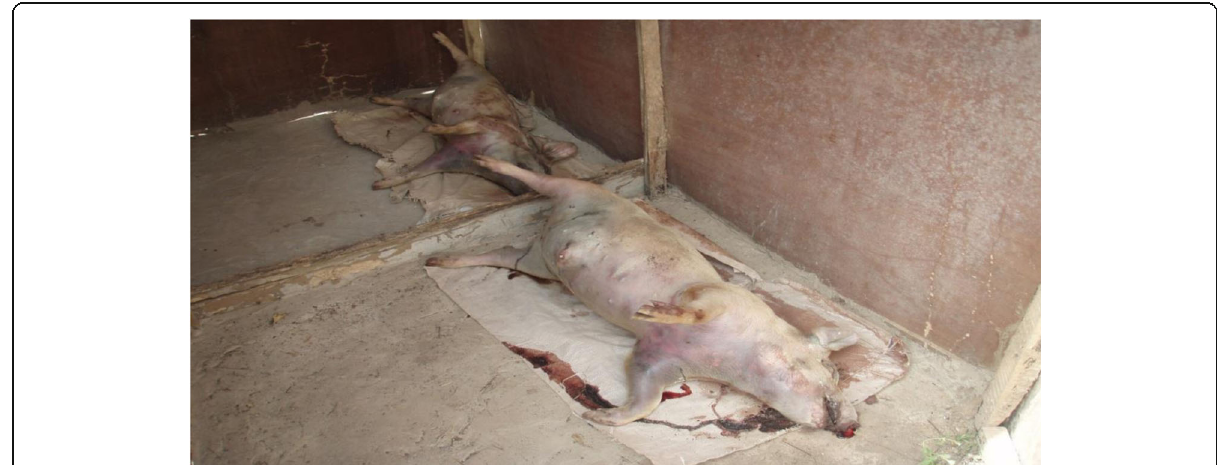
Fig. 2 Pig cadavers in the simulated building in Awka,